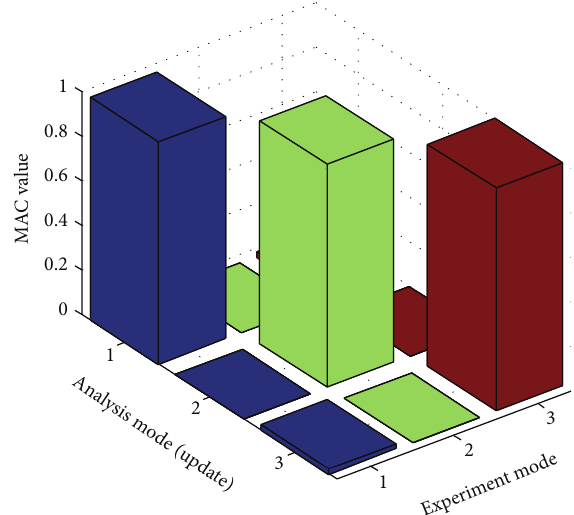
Figure 9: MAC plot (update and